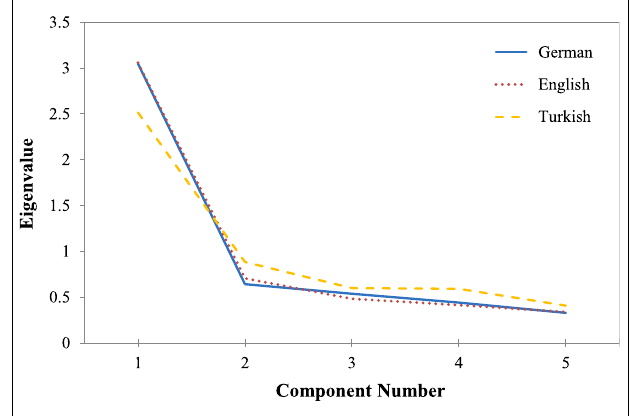
FIGURE 1 | Screen plot for exploratory factor analysis for each of the three language versions (Study 1a) .